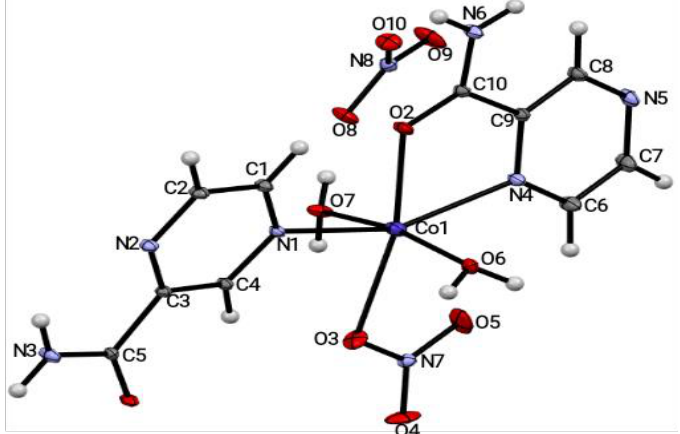
Figure 2. ORTEP diagram of 2 (010) showing atoms numbering. Red = oxygen, Purple = nitrogen, Grey = carbon, White = hydrogen, Blue = Cobalt